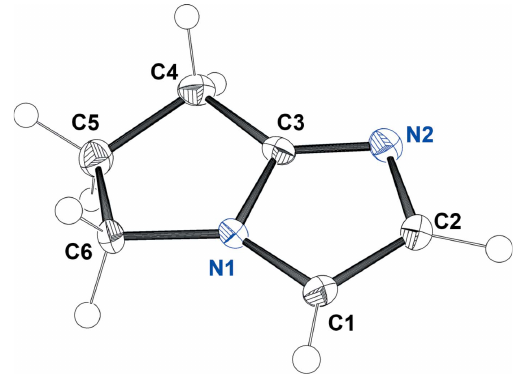
Figure 2 The molecular structure of ( II ) showing the atom-labeling scheme. Displacement ellipsoids are scaled to the 50% probability level.